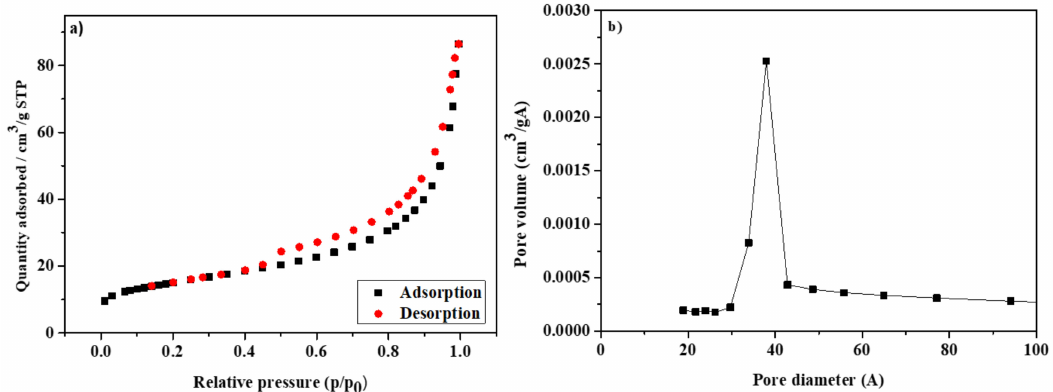
Figure 4. ( a ) Nitrogen adsorption–desorption isotherms at 77 K of NaP1CS, ( b ) pore diameter distribution of